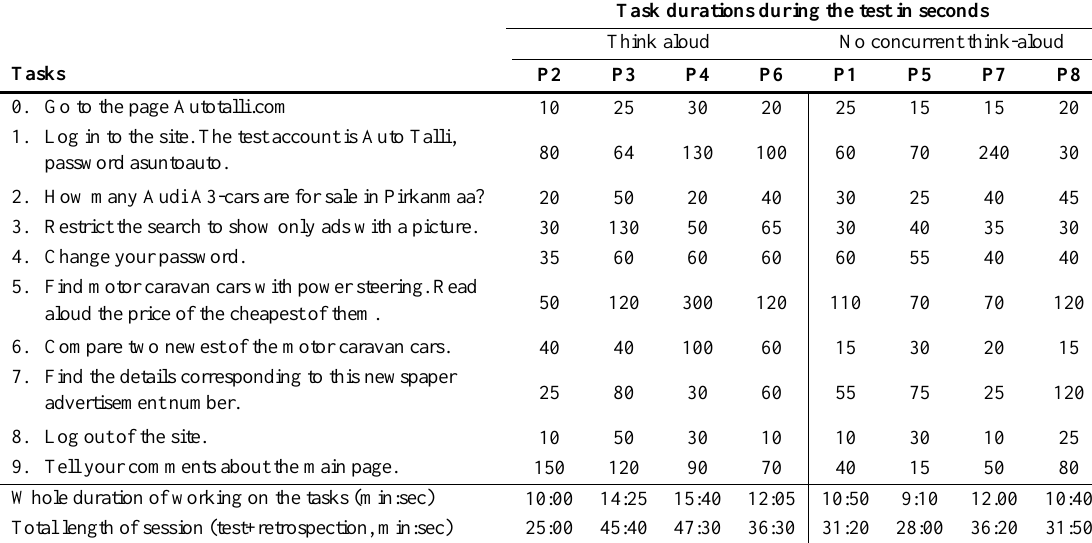
Table I Test tasks and their duration in seconds per participant (P1-P8).